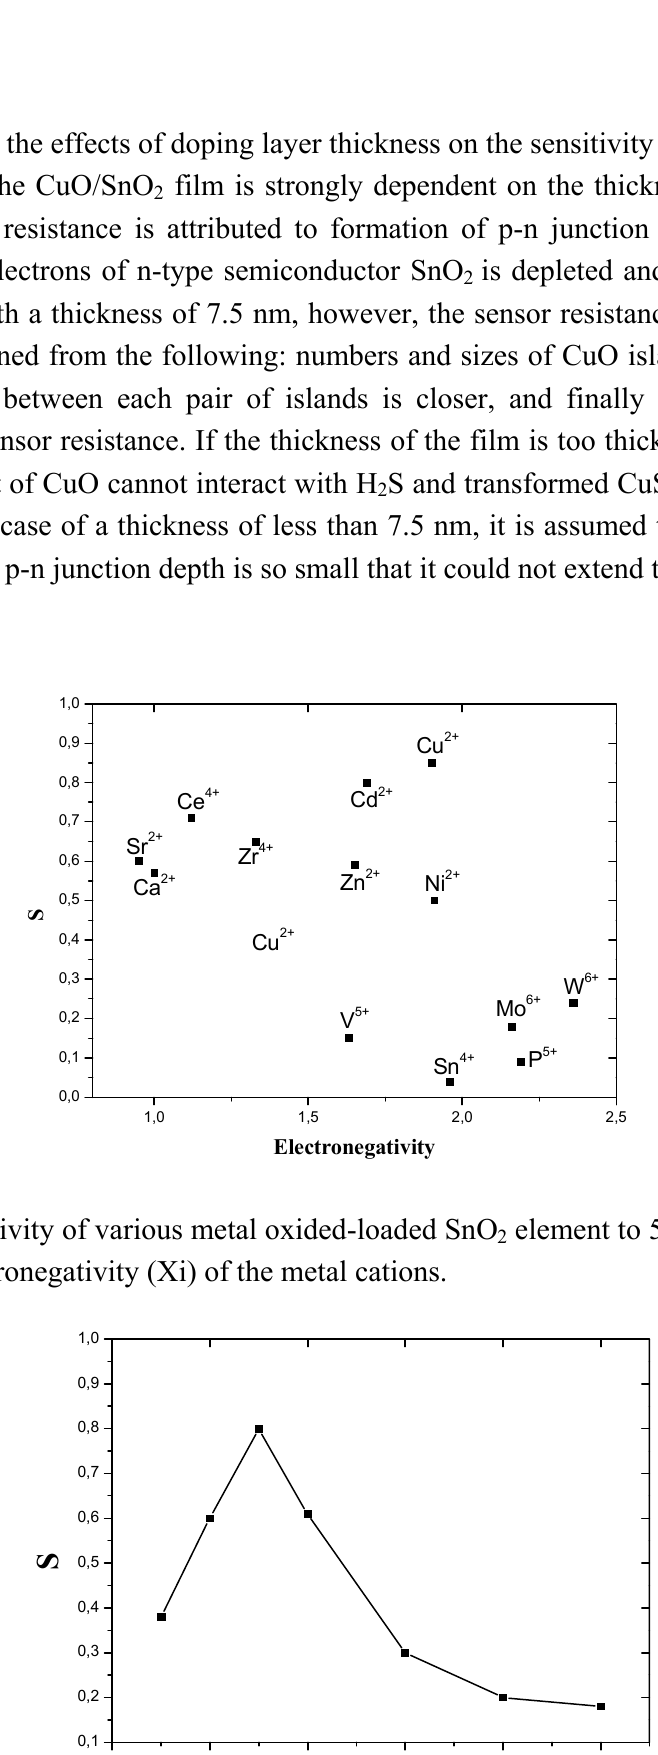
Figure 2. The dependence of sensitivity on the thickness of doping layer (1 ppm H